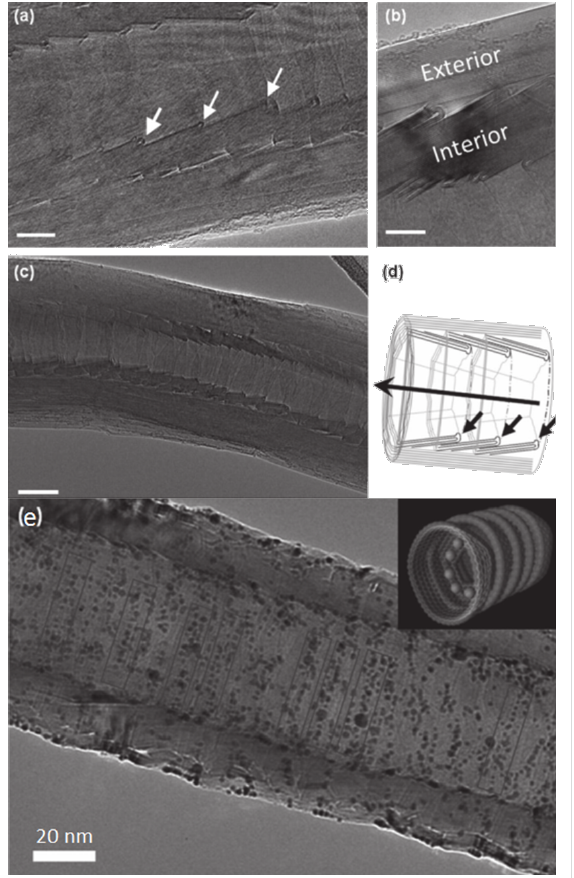
Figure 3: (a,b,c) Transmission electron micrographs of a hollow CVD- grown CNF with the graphene caps indicated by the white arrows. (d) Schematic of the structure of the CNFs with the caps as well as nucleation sites indicated by the black arrows. (e) Transmission elec- tron micrograph of the filled CNFs with gold nanoparticles. Inset: a computer generated model. Reprinted with permission from [30], copy- right 2012